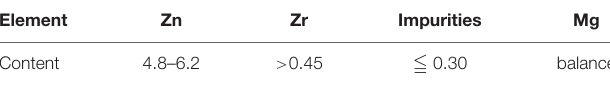
TABLE 1 | Compositions of ZK60 Mg alloy